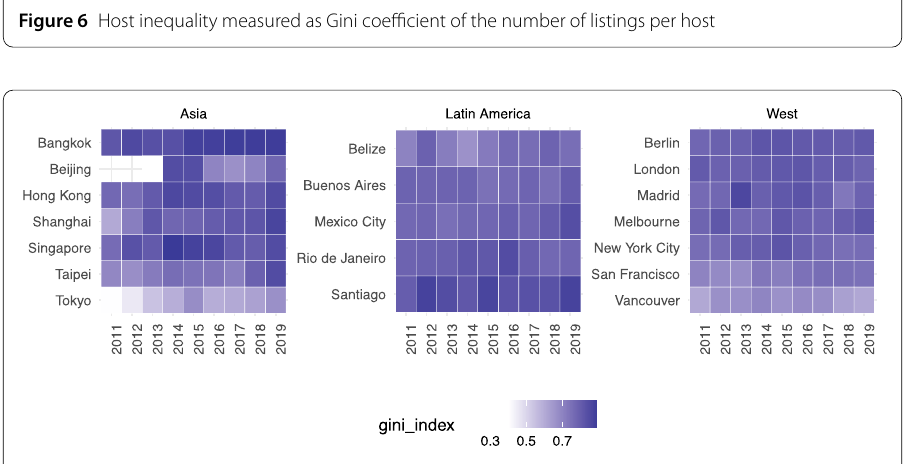
Figure 7 Host inequality measured as Gini coefficient of the number of listings per host per